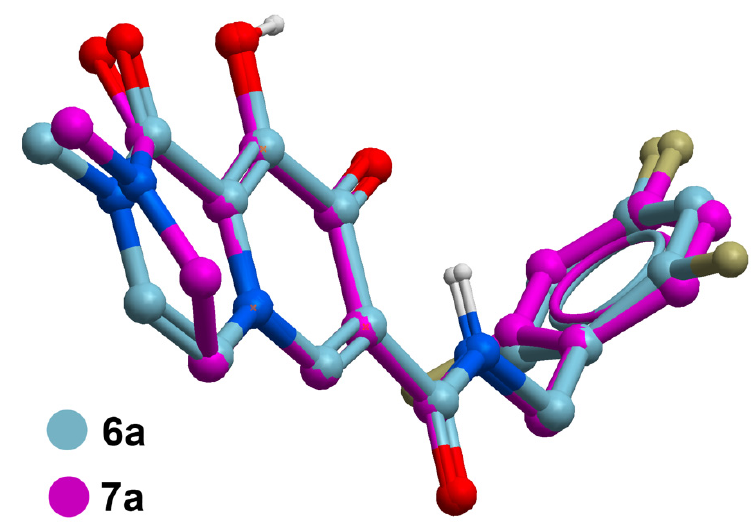
Figure 3. Superposition of in silico generated minimized structures of unsaturated 6a with the corresponding saturated analog 7a showing buckling of the respective B-rings that leads to a slight out-of-plane tilting of the B-ring carboxamide carbonyl. Structure generation and minimization was performed with MolSoft ICM software using standard parameters [35].